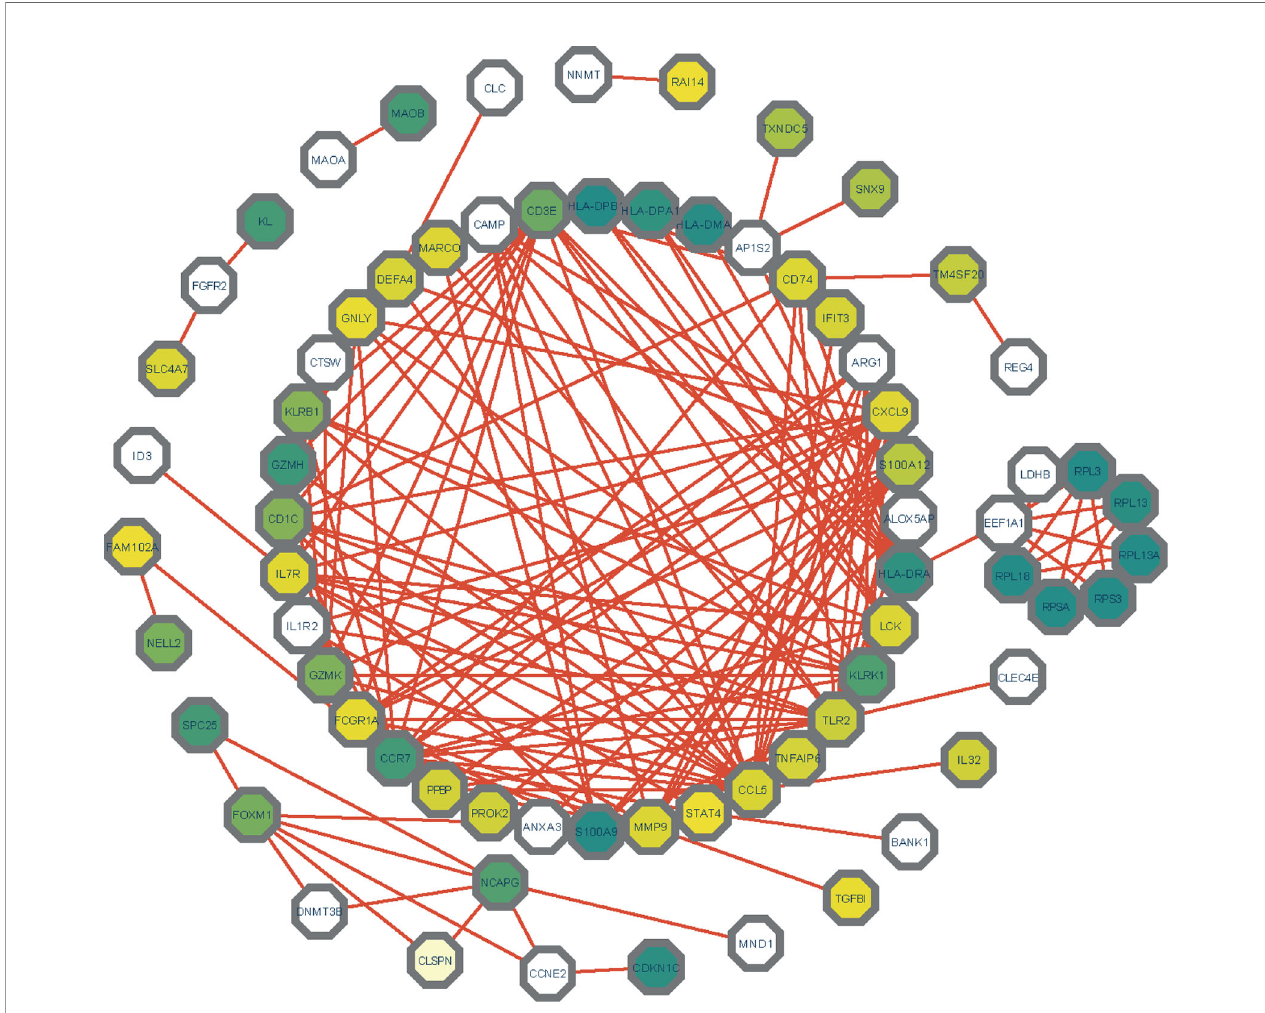
FIGURE 5 | The PPI network of common DEGs among COVID-19 and RA. In the fi gure, the octagonal nodes represent DEGs and edges represent the interactions between nodes. The PPI network was generated using String and visualized in